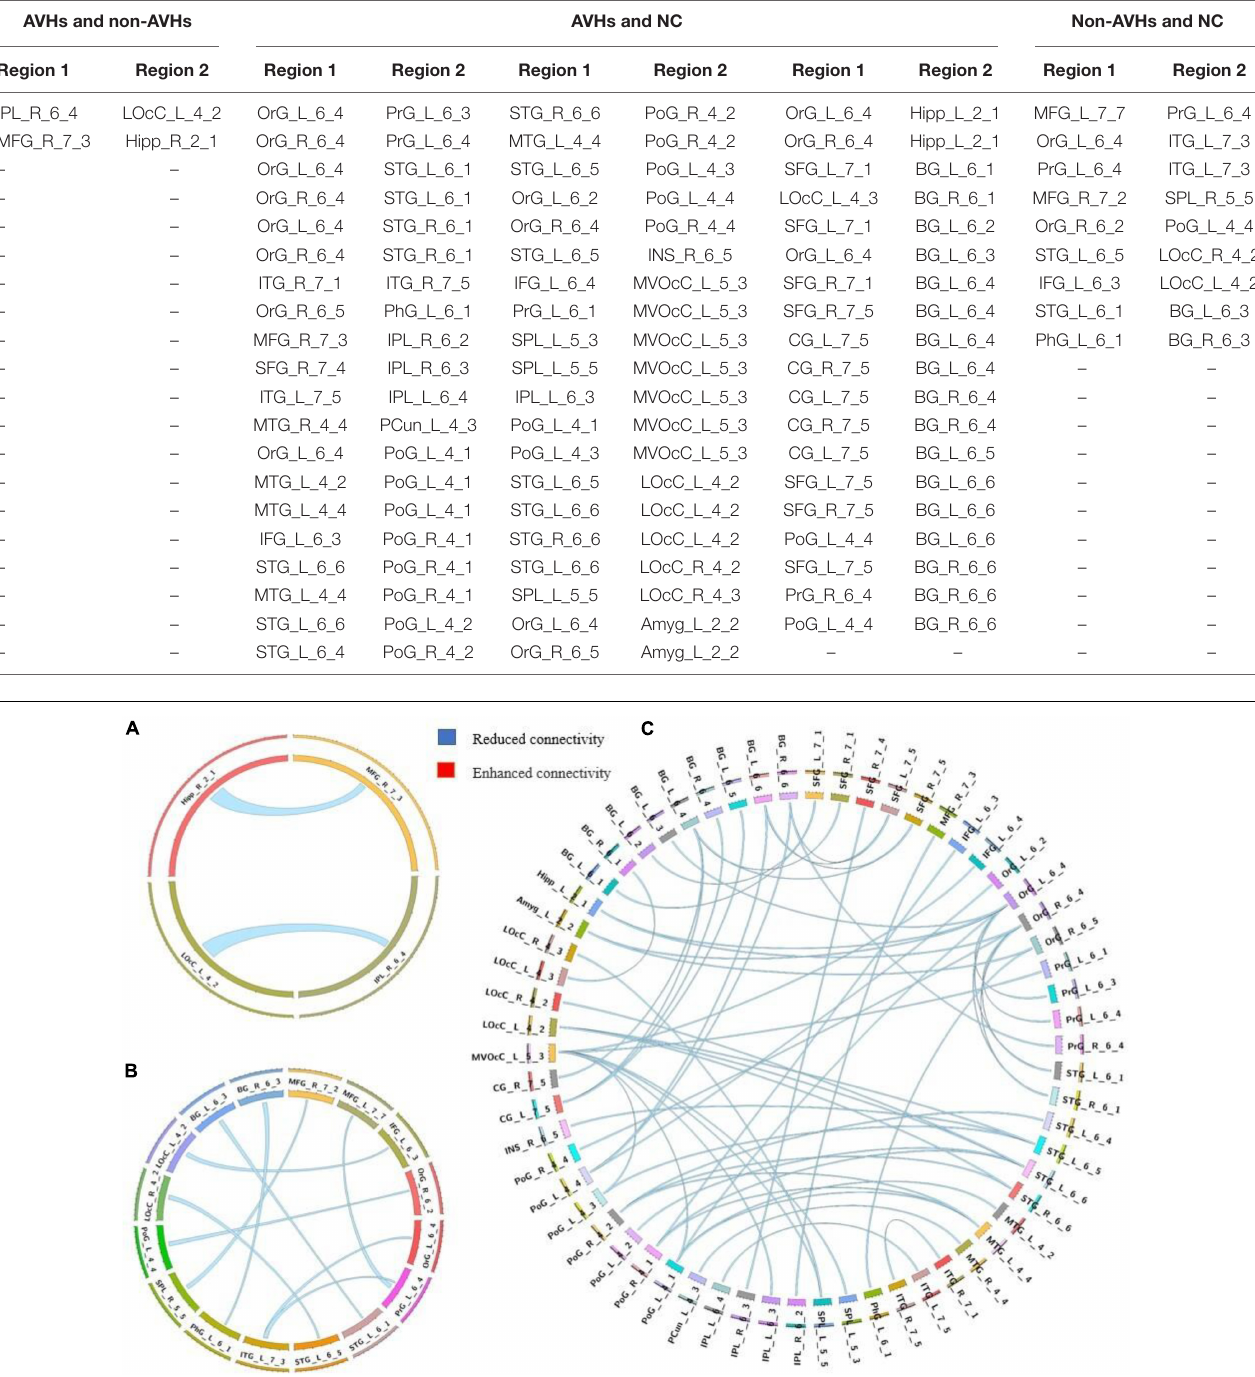
Although the between group differences with and without global signal regression consistently suggested mainly reduced static functional connectivity in patients with AVHs, compared to